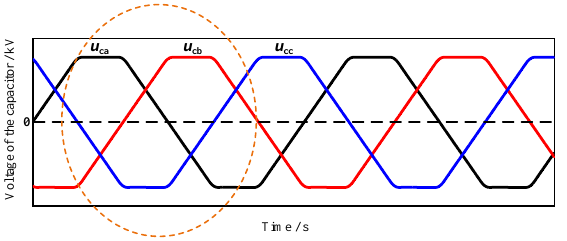
Figure 2. Diagram of a six-pulse CCC equivalent model at the inverter side.